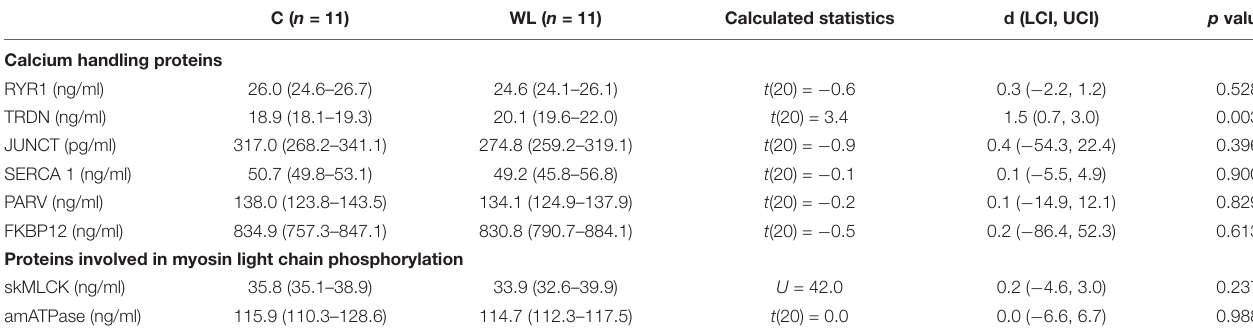
TABLE 4 | The content of proteins involved in calcium handling and in myosin light chain phosphorylation in medial